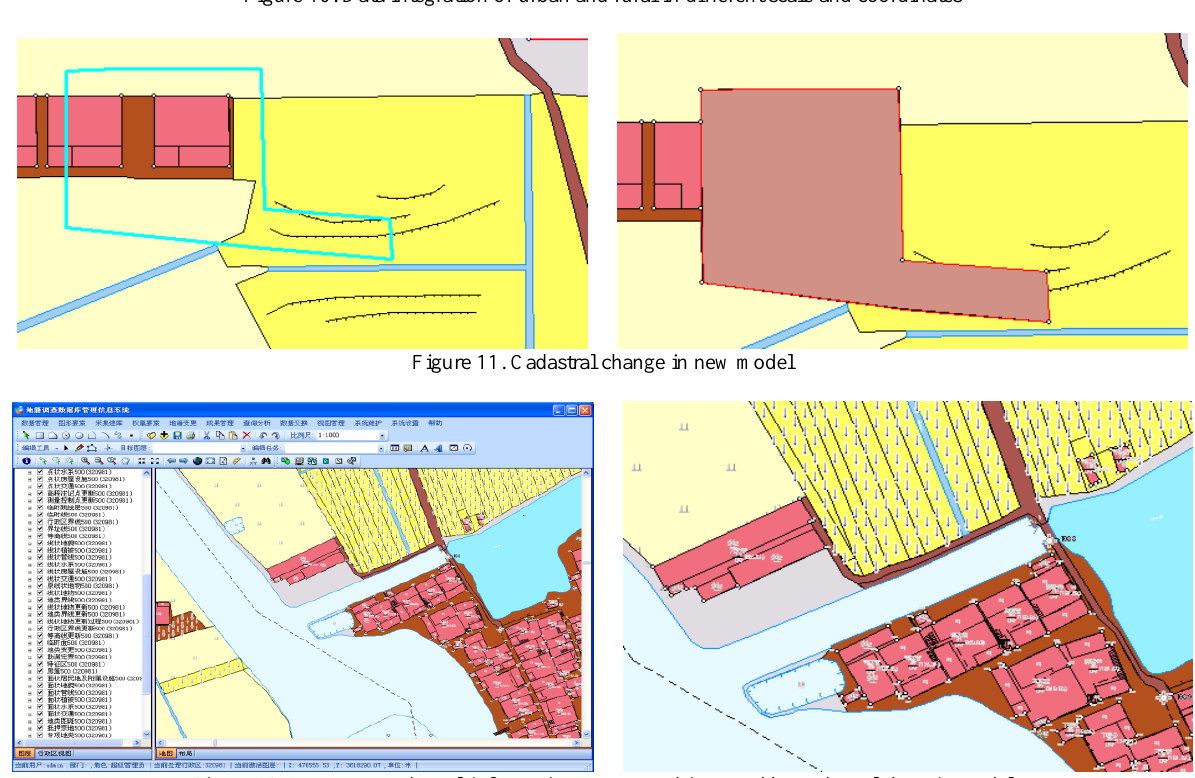
Figure 12. Prototype cadastral information system architectured by cadastral domain